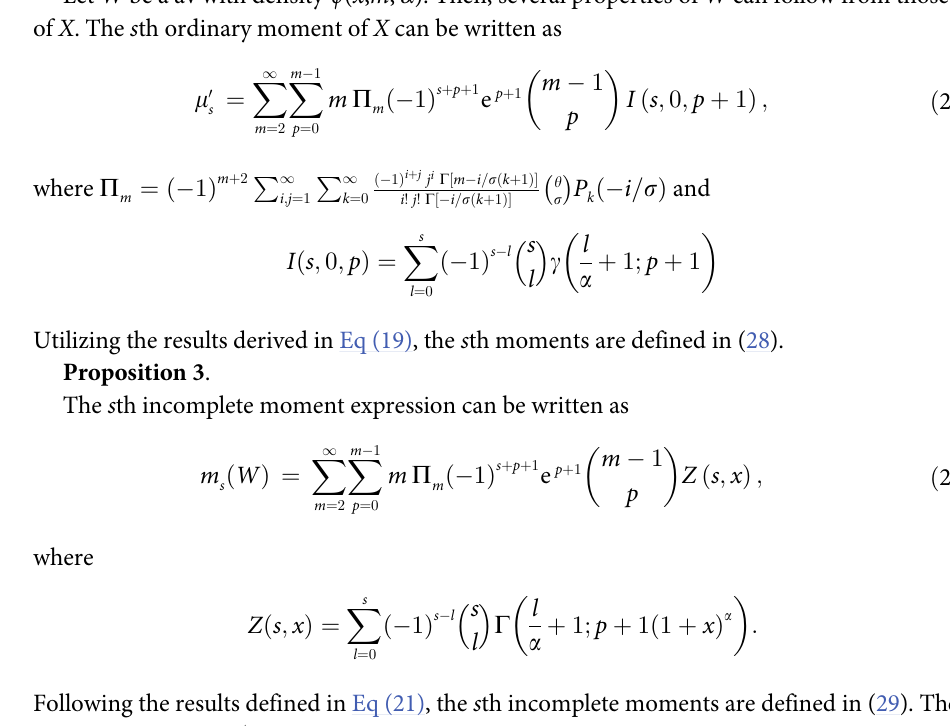
fourth standardized cumulants. The classical skewness (Fig 9) and kurtosis plots (Fig 10) of the